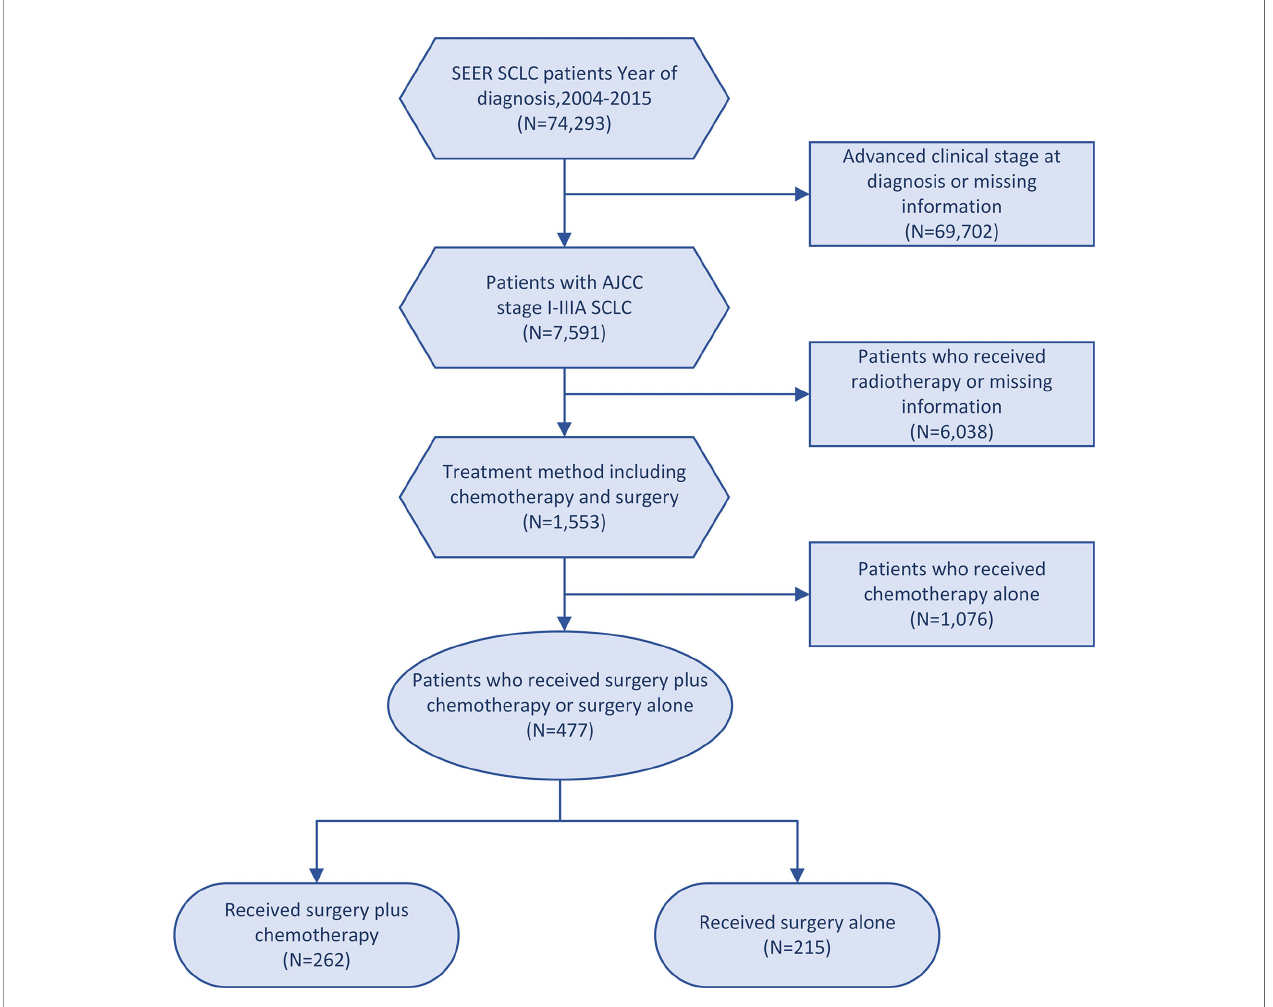
FIGURE 1 | Flowchart of patient selection